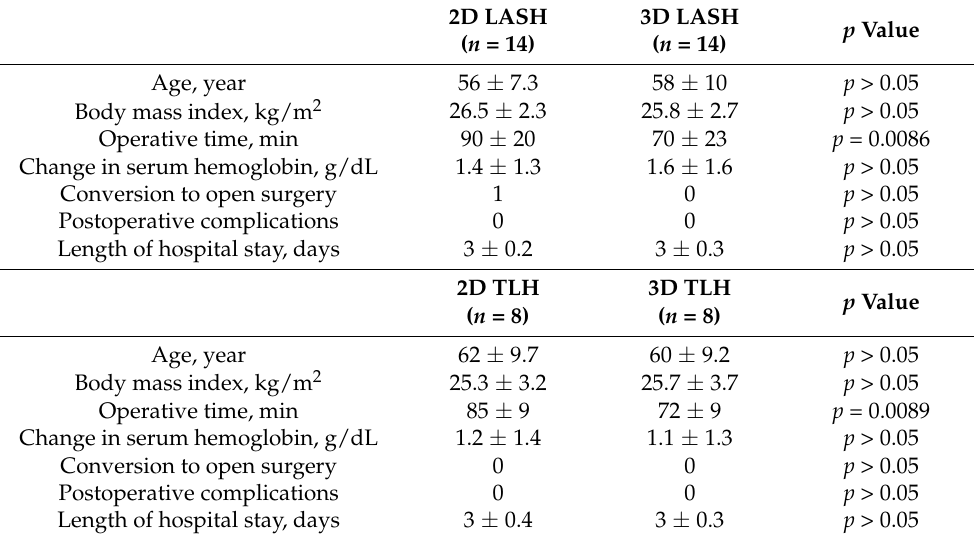
Table 2. Demographic data and surgical